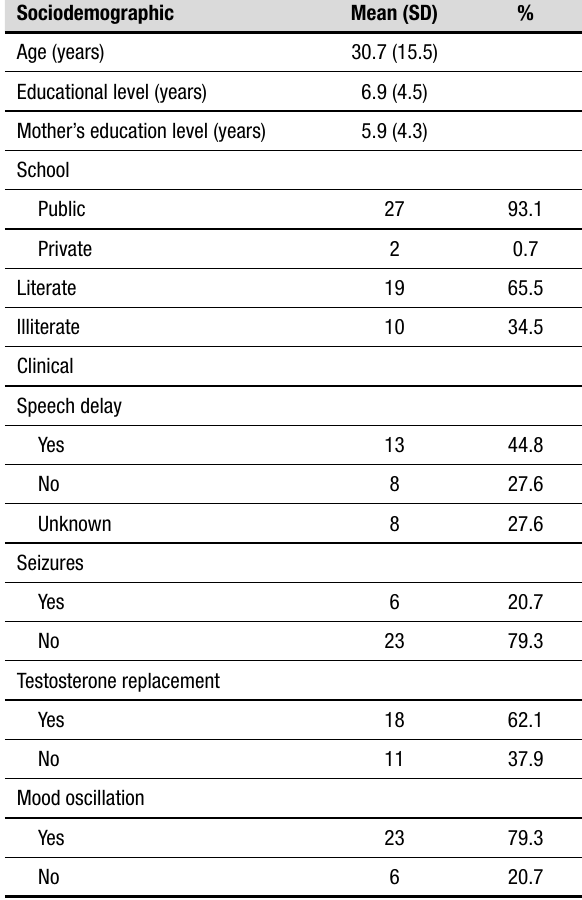
Table 1. Sociodemographic and clinical data of participants